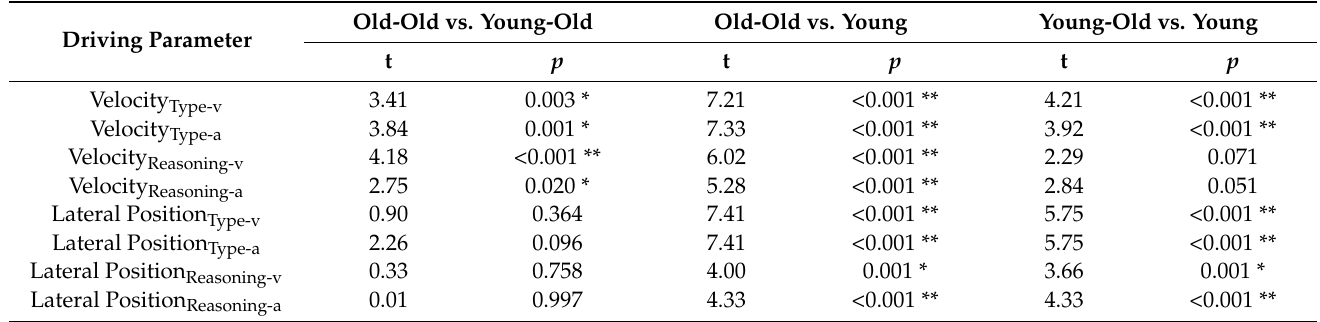
Table 4. Pair-wise comparisons for the effect of age on each driving performance variable score between age